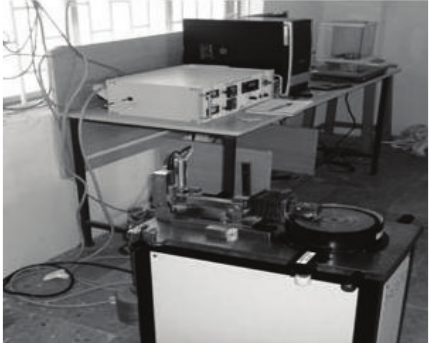
Figure 2: Experimental